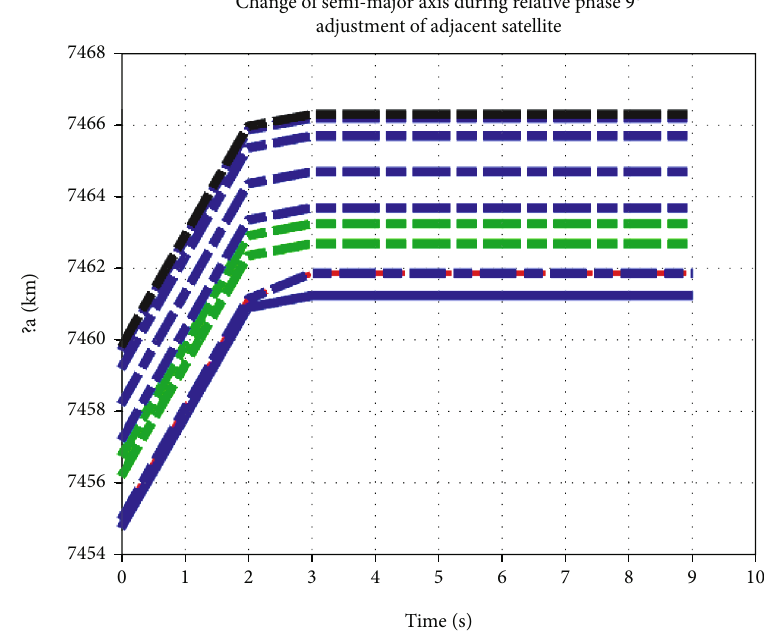
Figure 12: Schematic diagram of constellation initial phase deployment process.